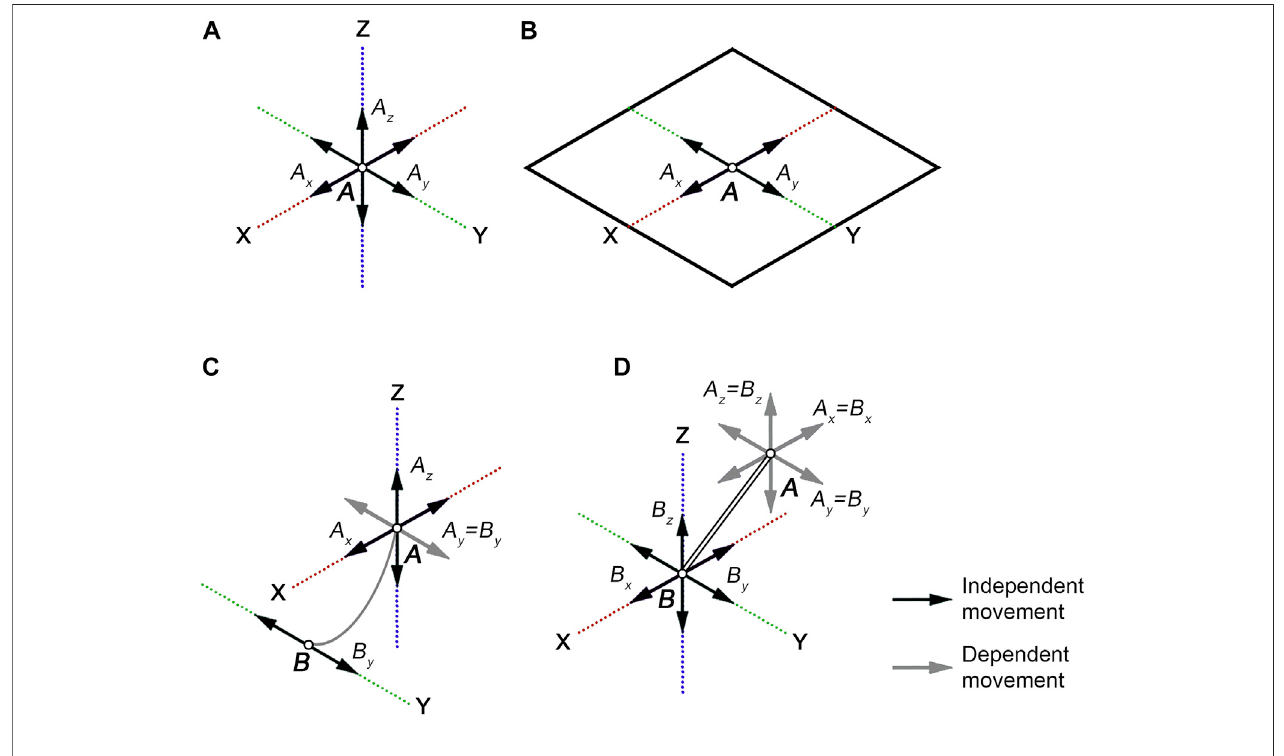
FIGURE 4 | The number of node variables changes under the constraint: (A) Independent movement of node A; (B) Node A in XY-plane cannot move along the Z-axis; (C) Node A follows node B along the Y-axis; (D) Movement of Node A depends on node B completely in 3 dimensions.